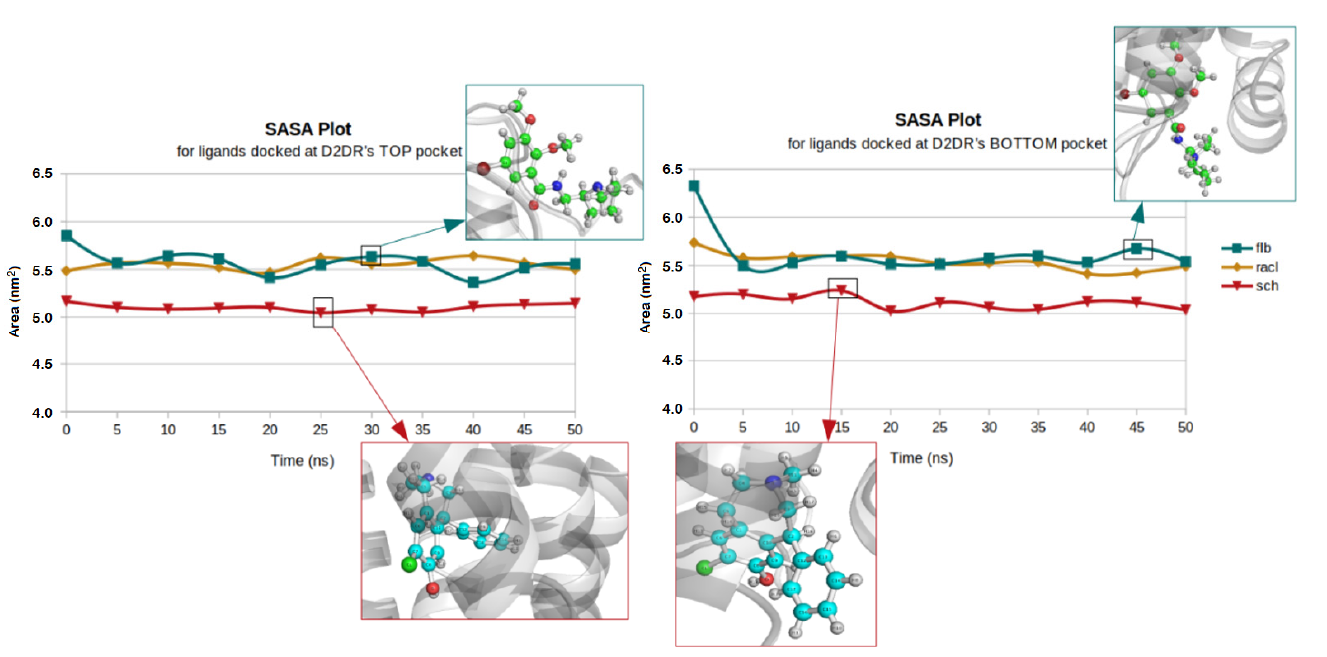
Figure 3. SASA profiles for ligands docked at D2DR’s top ( left ) and bottom ( right ) positions.